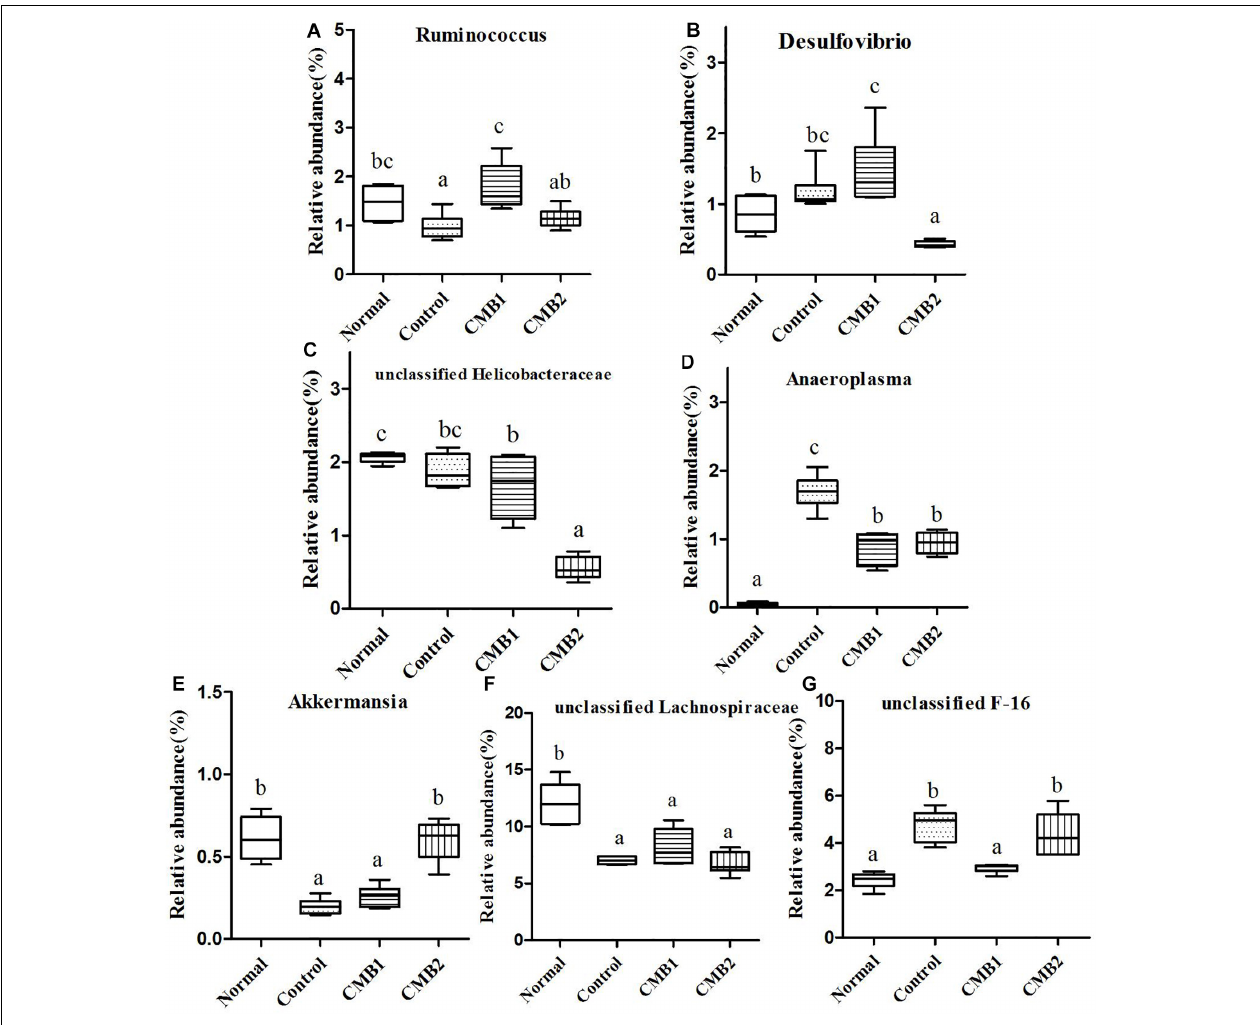
FIGURE 8 | Relative abundance (%) of caecal microbial taxa at the genus level in constipated mice fed CMB. (A) Ruminococcus , (B) Desulfovibrio, (C) unclassified Helicobacteraceae, (D) Anaeroplasma , (E) Akkermansia, (F) unclassified Lachnospiraceae, and (G) unclassified F-16.